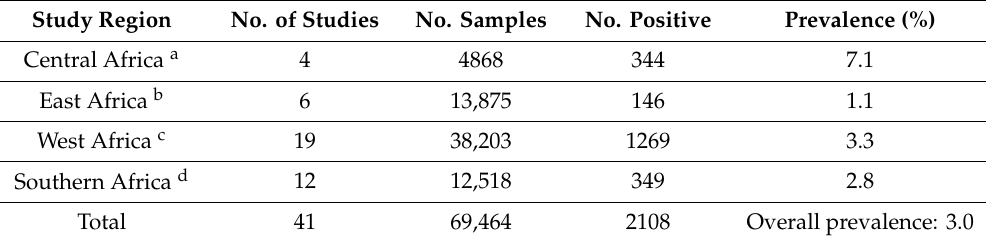
Overall prevalence: 3.0